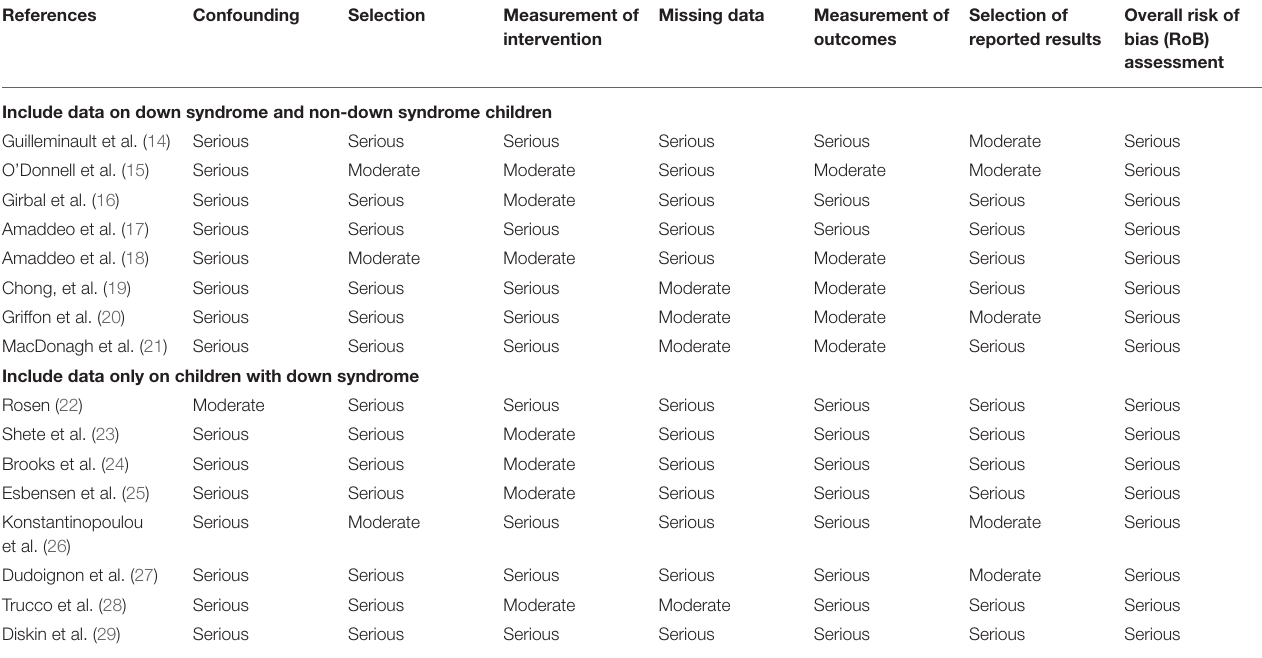
TABLE 3 | Assessment of risk of bias in individual studies included in the systematic review of long-term non-invasive ventilation use in children with down syndrome using the risk of bias in non-randomized studies—of interventions (ROBINS-I)